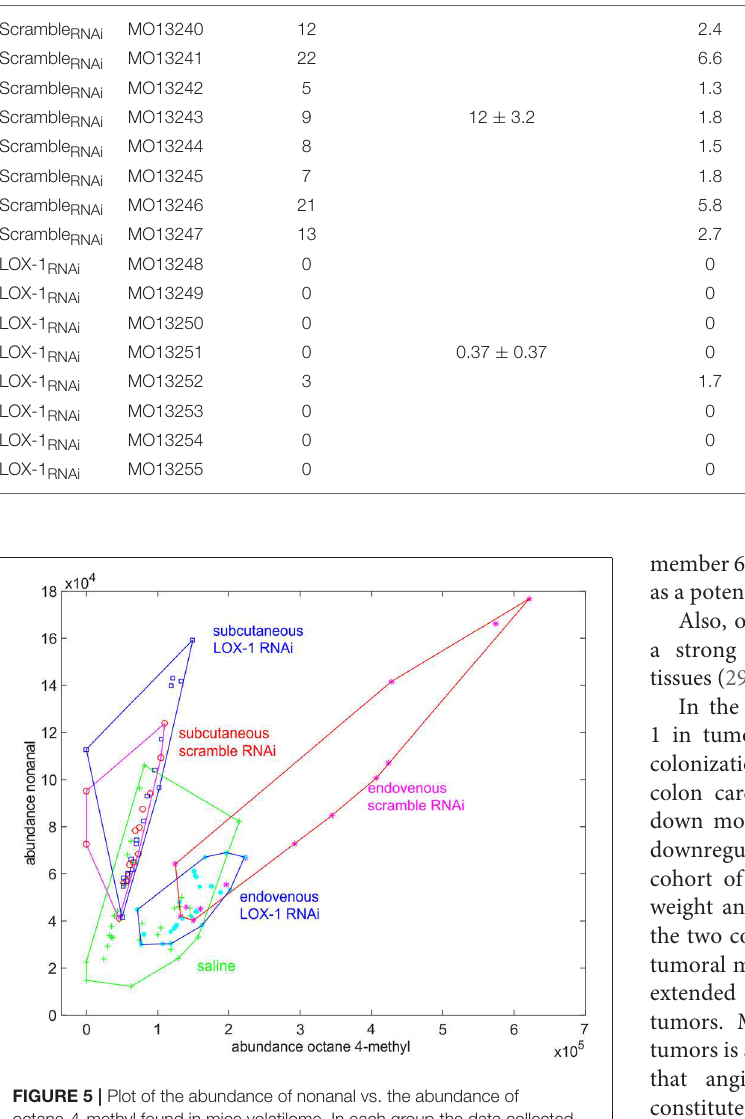
TABLE 2 | Morphometric analysis of metastatic spread of LOX-1 RNAi and scramble RNAi DLD-1 cells in murine organs evaluated on H&E sections. Treatment Animal